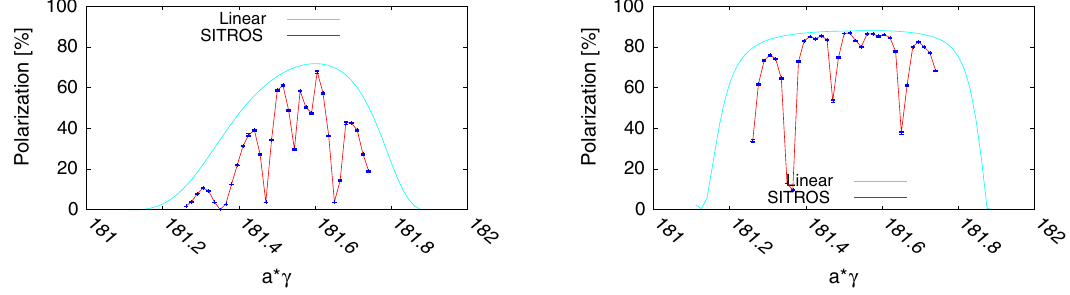
FIG. 9. 60 ° = 60 ° FODO. Left: Polarization vs. spin tune after orbit is corrected with 1096 correctors with δ Q y ¼ 200 μ m and no BPMs errors. Right: adding the correction of δ ˆ n 0 through orbit bumps.